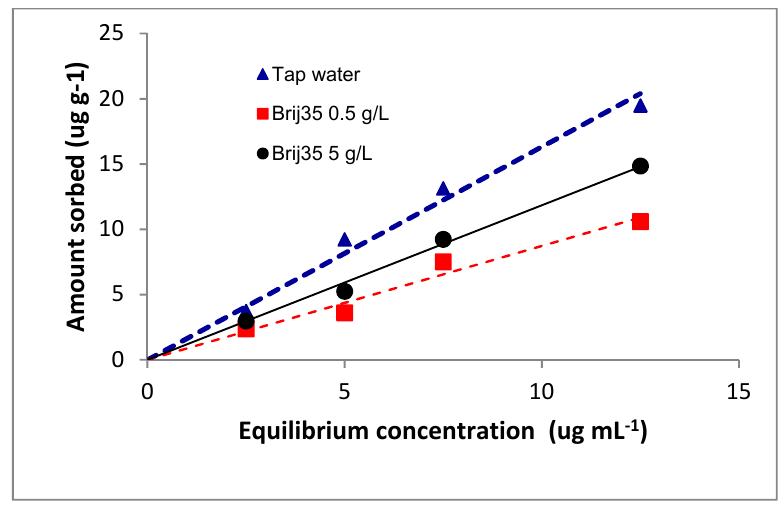
, R 2 and K values for metribuzin sorption in the d oc